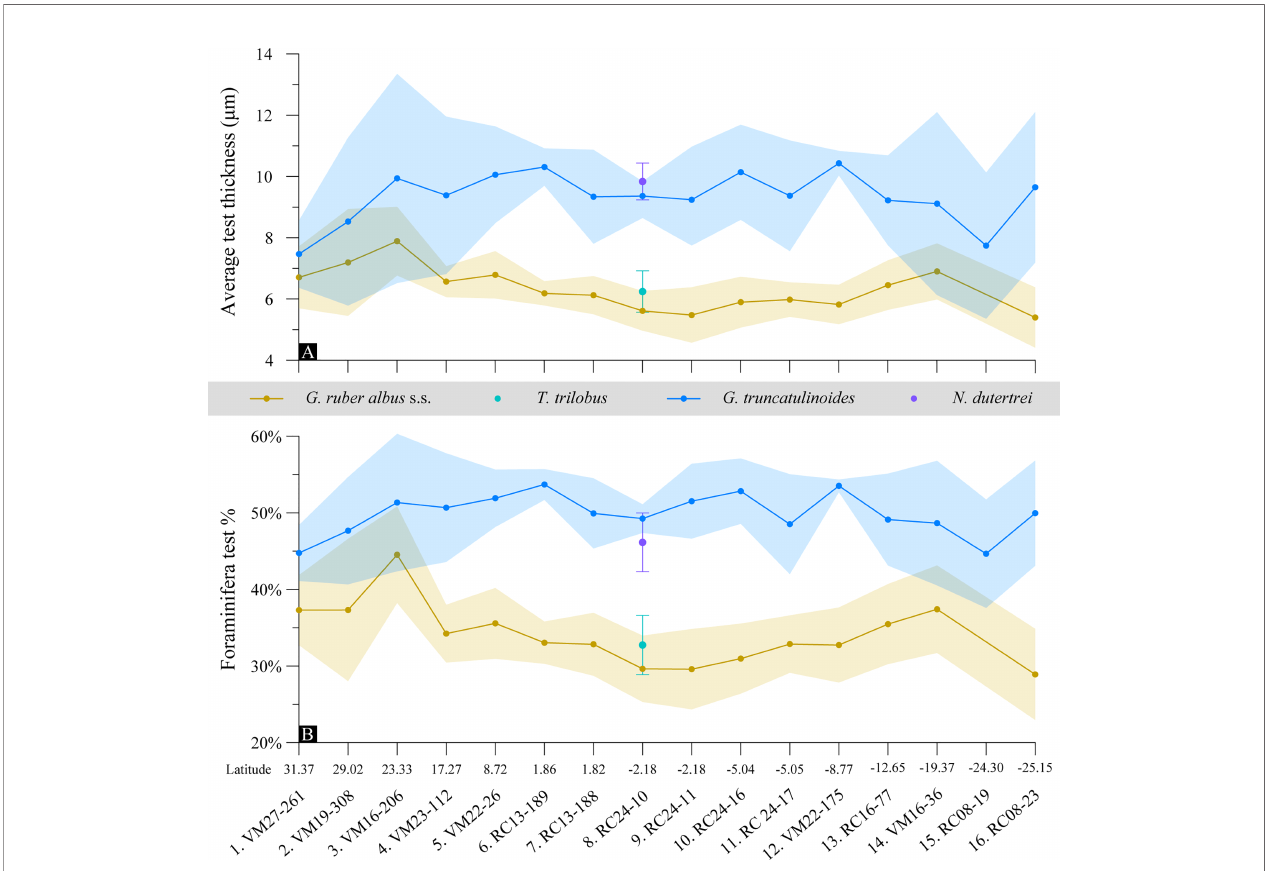
FIGURE 8 | (A) Average thickness of the XMCT scanned foraminifera tests along the study transect; (B) species-speci fi c average calcite test volume percentage in the total foraminifera cell. The shaded areas depict the 1 s con fi dence interval in